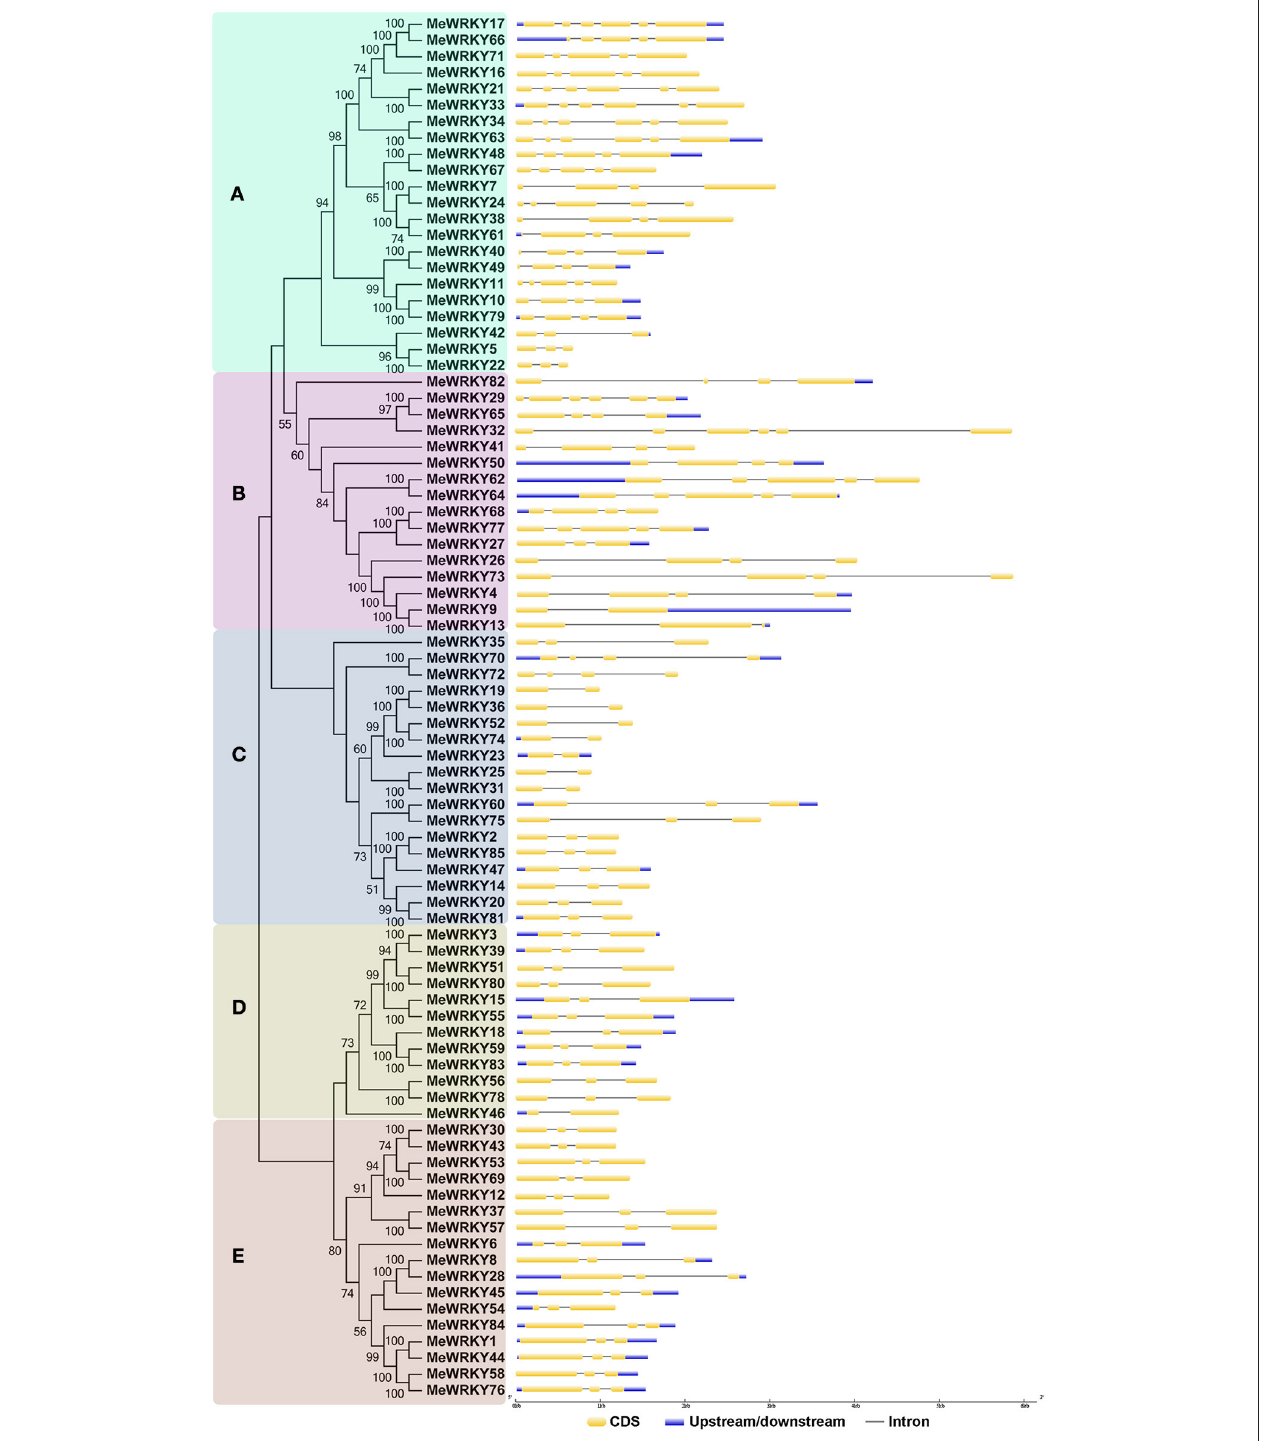
FIGURE 3 | The exon-intron structure of MeWRKY genes according to the phylogenetic relationship. The unrooted phylogenetic tree was constructed based on the full length sequences of MeWRKYs with 1000 bootstraps. Exon-intron structure analyses of MeWRKY genes were performed by using the online tool GSDS. Lengths of exons and introns of each MeWRKY gene were exhibited proportionally. (A–E) indicates different groups of WRKY family in cassava.